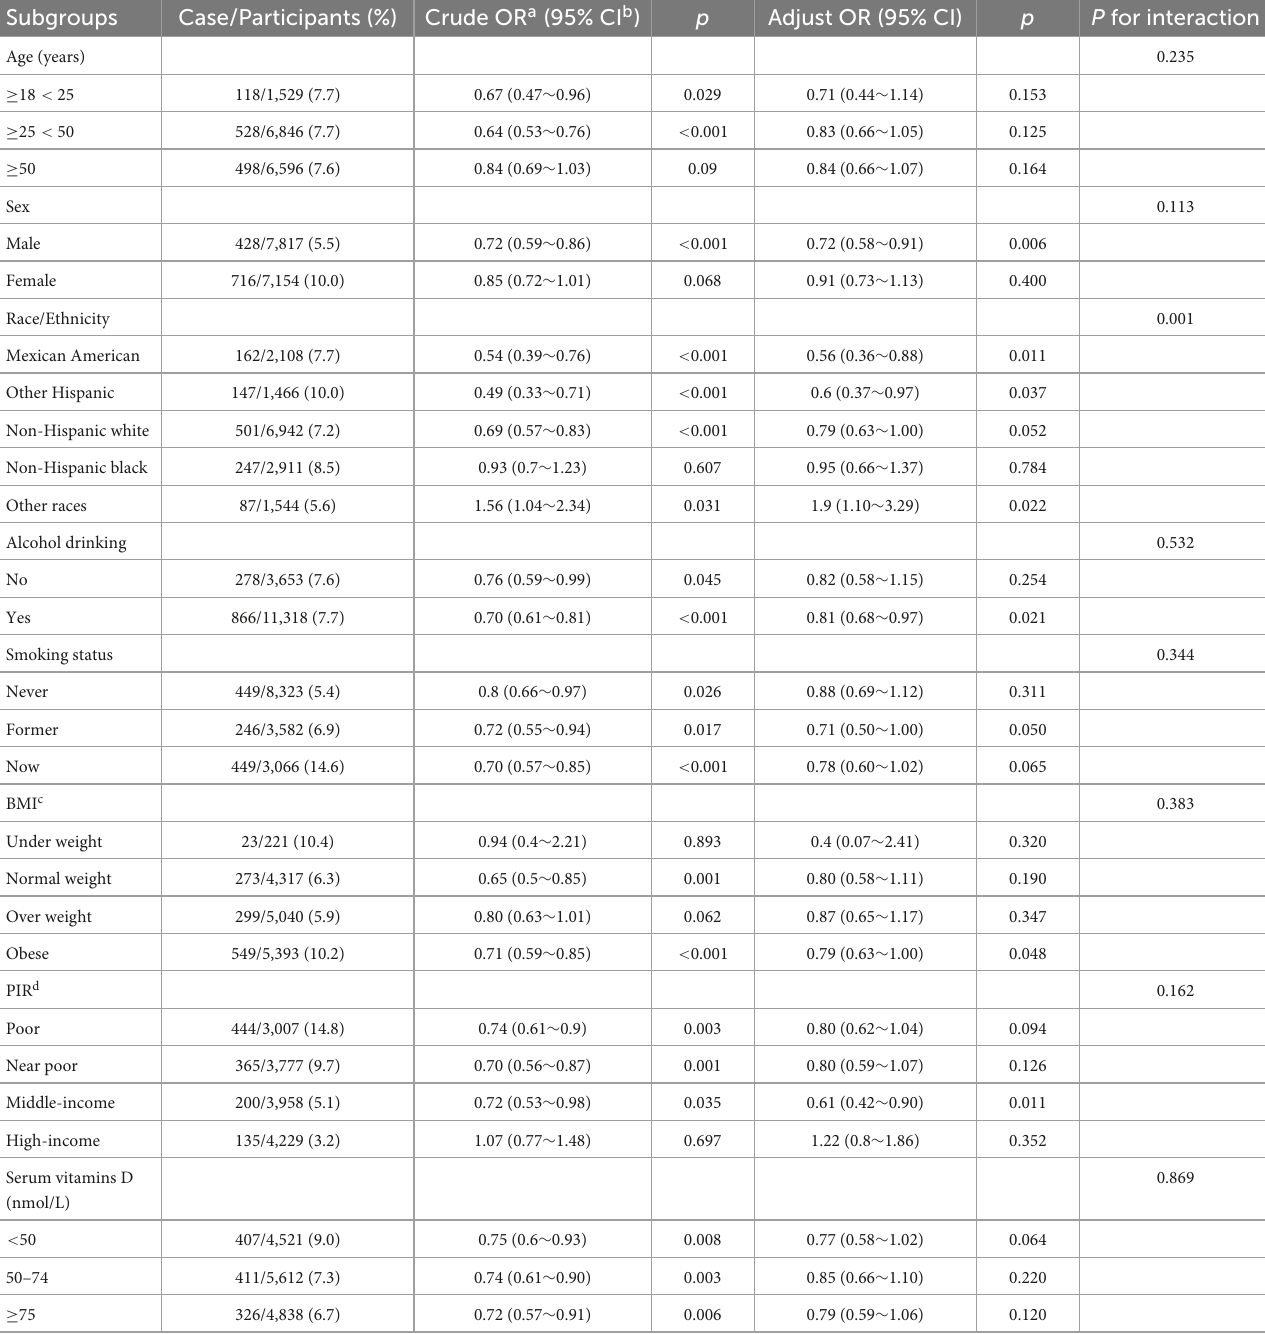
TABLE 4 Association between depression and calcium (Ca) intake in